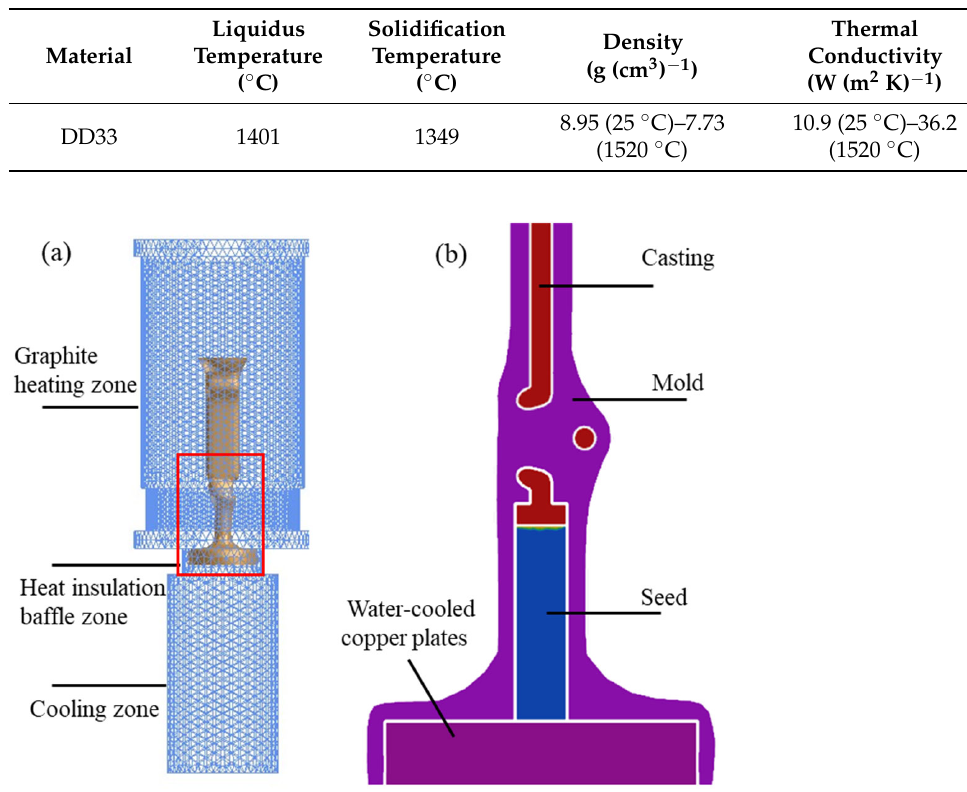
Table 1. Thermophysical properties of the materials used in the simulation.